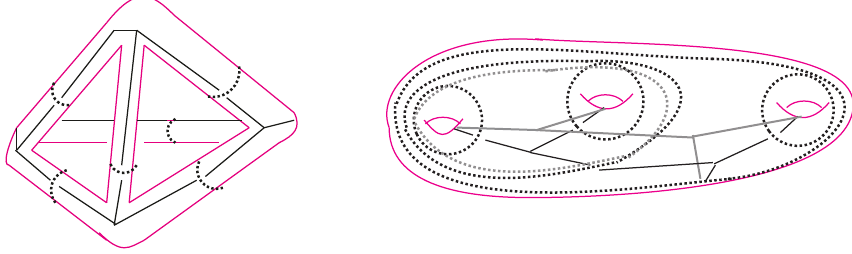
Figure 3 . The left panel shows a B 1 basis for the two-tetrahedra-triangulation of the 3-sphere. Here we did not depict the over-crossing graph copy F u and the vacuum loops associated to the 2-handle constraints. This copy can be transformed, using sliding across the 2-handle vacuum loops, to the same 2-handle vacuum loops. The basis is labelled by six quantum numbers and diagonalizes Wilson loop operators around the (six) edges of the triangulation. The right panel shows a B 2 basis. The strands and vacuum loop on the backside of the genus 3 surface are depicted in grey. Note that for both bases we have 6 vacuum loops. But always three vacuum loops can be generated from the other three loops, using the projection property (modulo factors of D ) and the sliding property of the loops. The graph F u can be identi(cid:12)ed with the one-skeleton of the dual complex to the triangulation: two four-valent nodes (expanded into three-valent ones) representing the two tetrahedra and connected with each other by four links, representing the four triangles. This basis diagonalizes Wilson loop operators around the four triangles of the triangulation and in addition two Wilson loops around pairs of